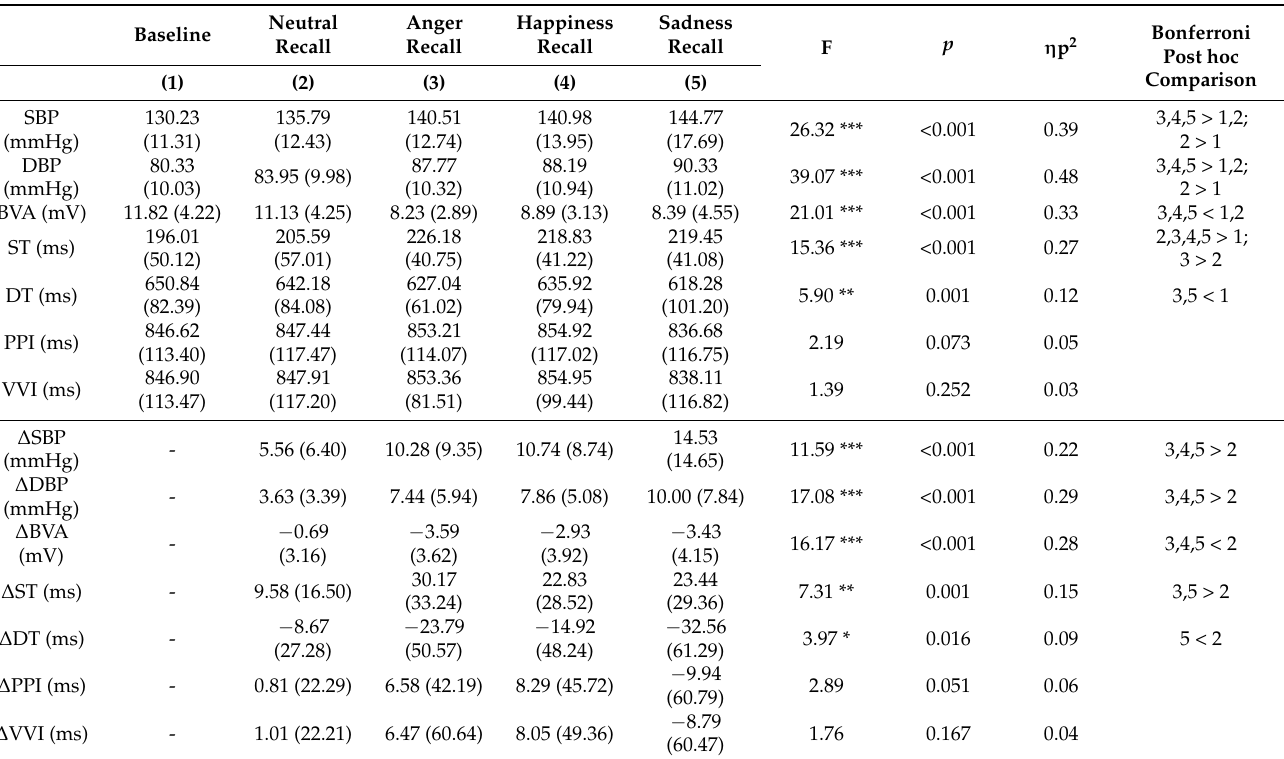
Table 2. The raw and change scores of blood pressure and photoplethysmography at different experimental stages (n = 43).